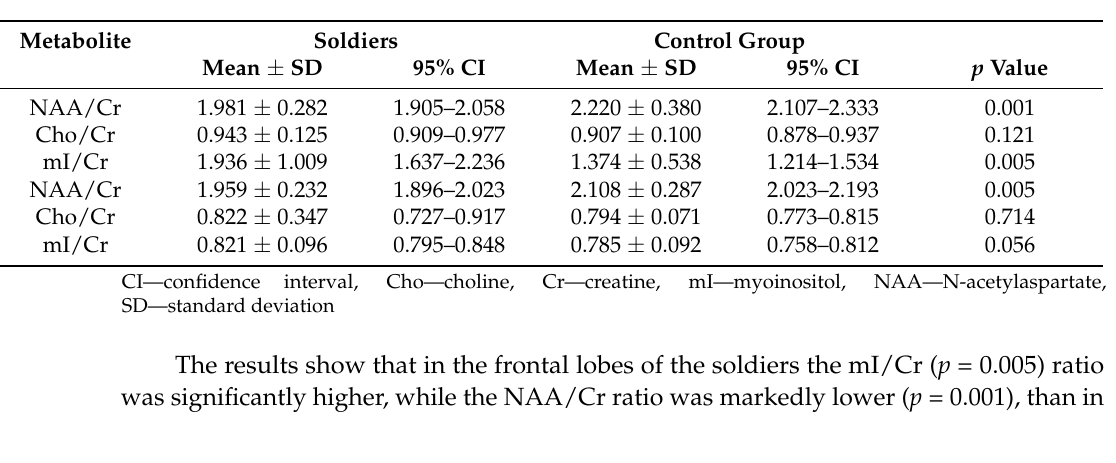
Table 3. The comparison of mean relative concentrations of metabolites in the frontal and occipital lobes between soldiers and